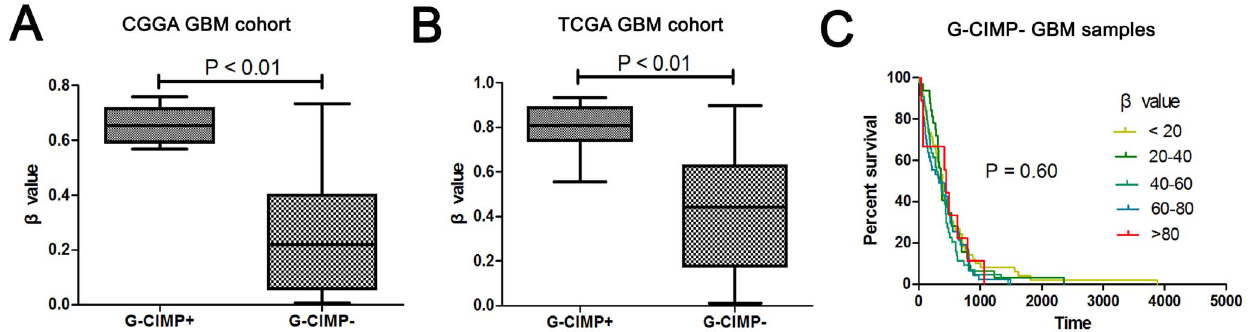
Figure 2. G-CIMP status in CGGA and TCGA cohort. A. In the CGGA GBM cohort, the b values of the SOCS3 promoter of the two groups (G- CIMP-positive group and G-CIMP-negative group) displayed statistically significant difference (P , 0.01). B. In the TGGA GBM cohort, the b values of the SOCS3 promoter of the two groups (G-CIMP-positive group and G-CIMP-negative group) also displayed statistically significant difference (P , 0.01). C. In the G-CIMP-negative TCGA samples, there was no significant difference among the five groups